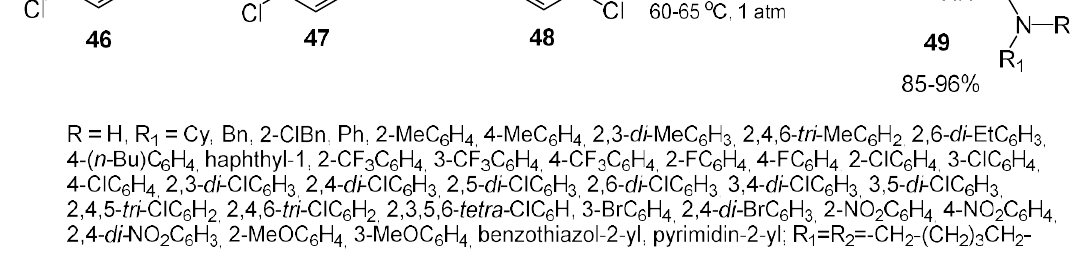
-carbamothioyl)benzamides 1